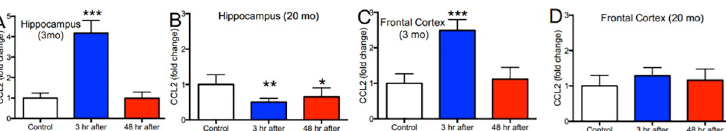
Fig 3. Isoflurane produces age- and region-dependent changes in CCL2 expression. Mice were anesthetized as described and CCL2 measured by RT-PCR. CCL2 was upregulated transiently in both regions in young mice after anesthesia (panels A & C). In old mice, however, isoflurane had no effect in the cortex (D) but persistently decreased CCL2 in the hippocampus (panel B). Data expressed as mean ± SD; N = 5 animals per treatment condition. � p < 0.05, �� p < 0.01, ��� p < 0.001 relative to age-matched controls by 1-way ANOVA with Dunnett’s